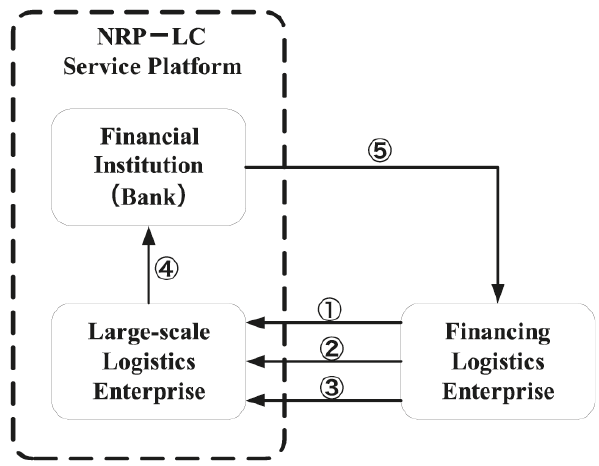
Figure 3: The prepaid accounts control process (1, 2 & 3 - flows of budget information, deposit and settlement request; 4 - acceptance bills; 5 - service bill)